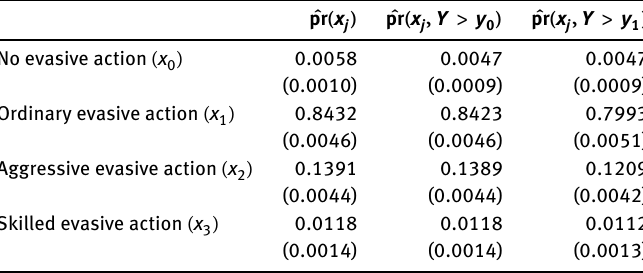
Table 3: Unbiased estimates and standard